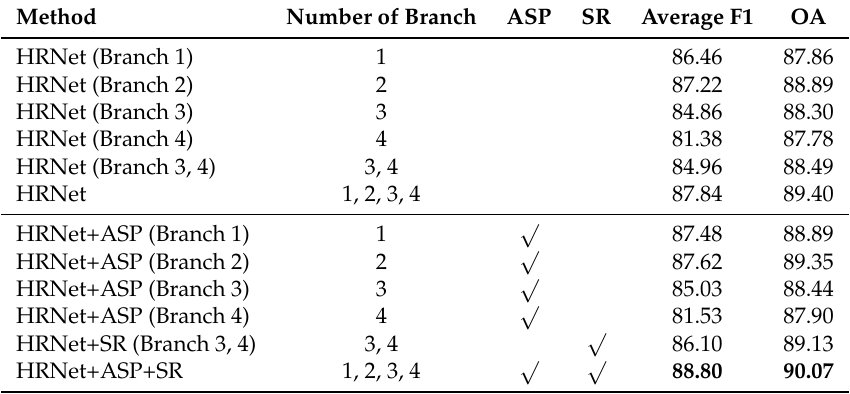
Table 2. Results of the ablation study on the Vaihingen dataset.